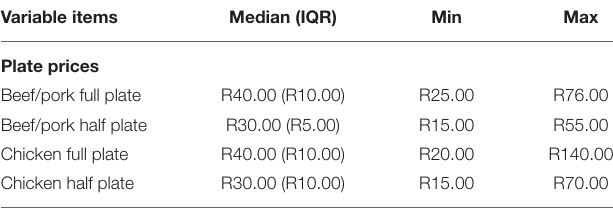
TABLE 5 | Street food plate